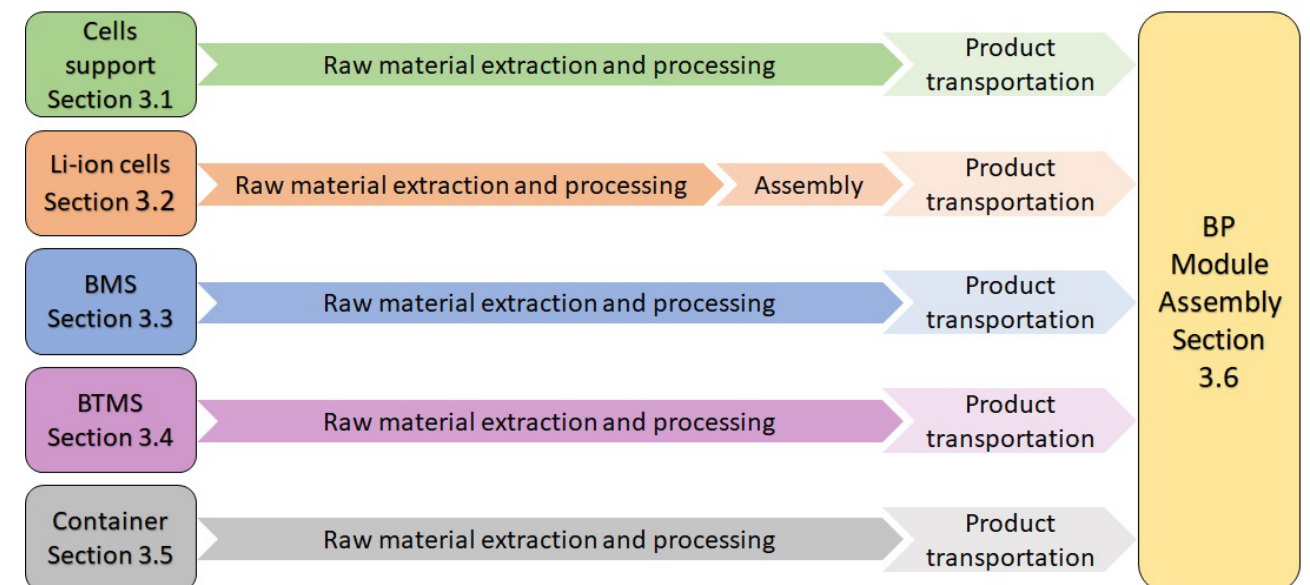
Figure 3. A scheme of the LCA analysis carried on in the